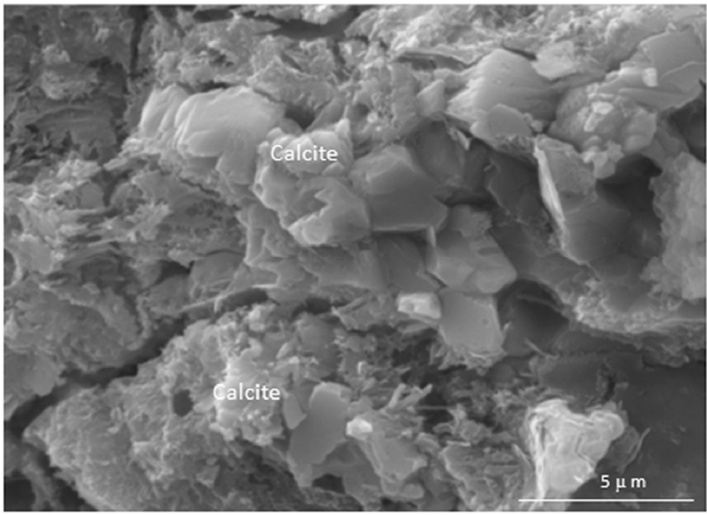
Figure 7. Morphology of compounds in 4 days carbonated 20% ACW.